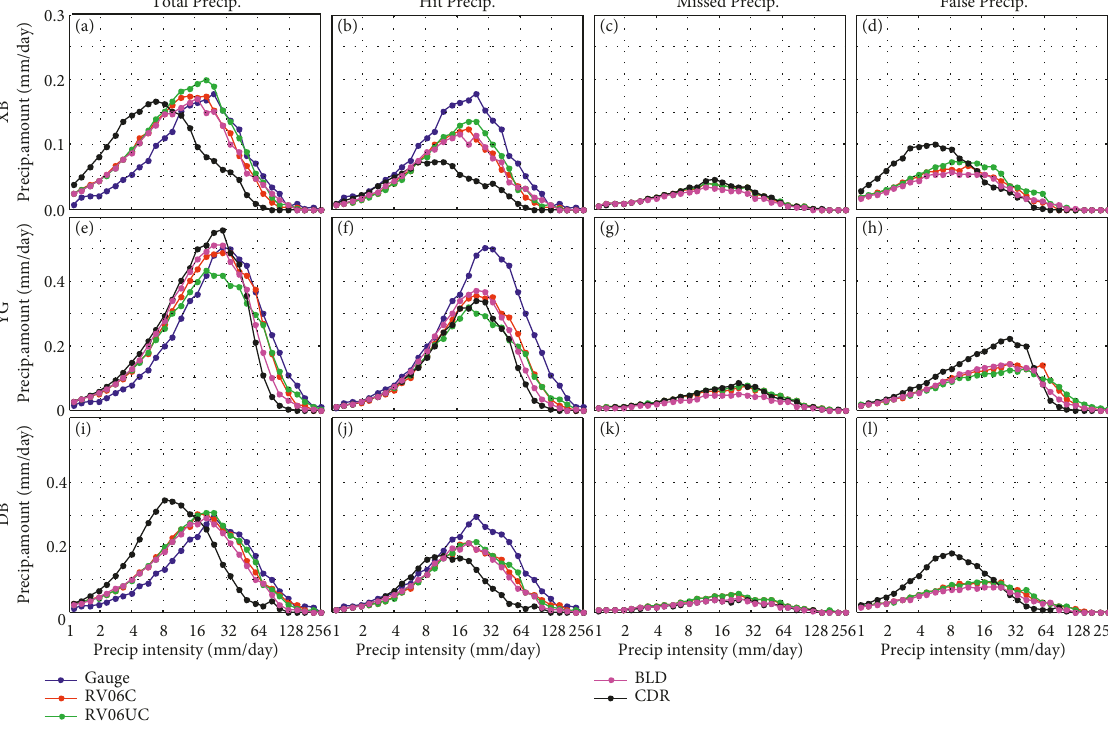
Figure 13: Same as Figure 12 except for the XB, YG, and DB subregions.